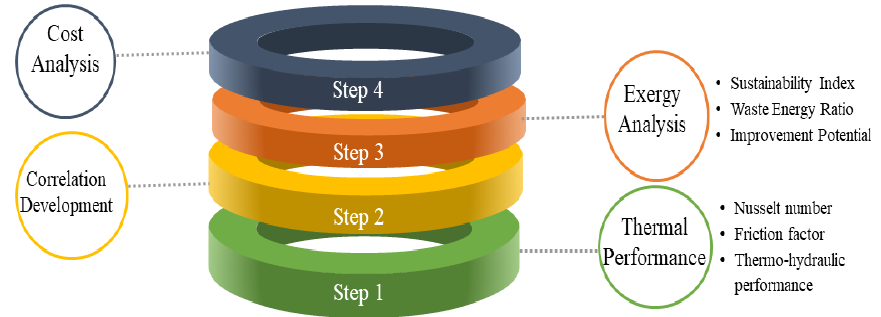
Figure 2. Methodology of the present investigation.